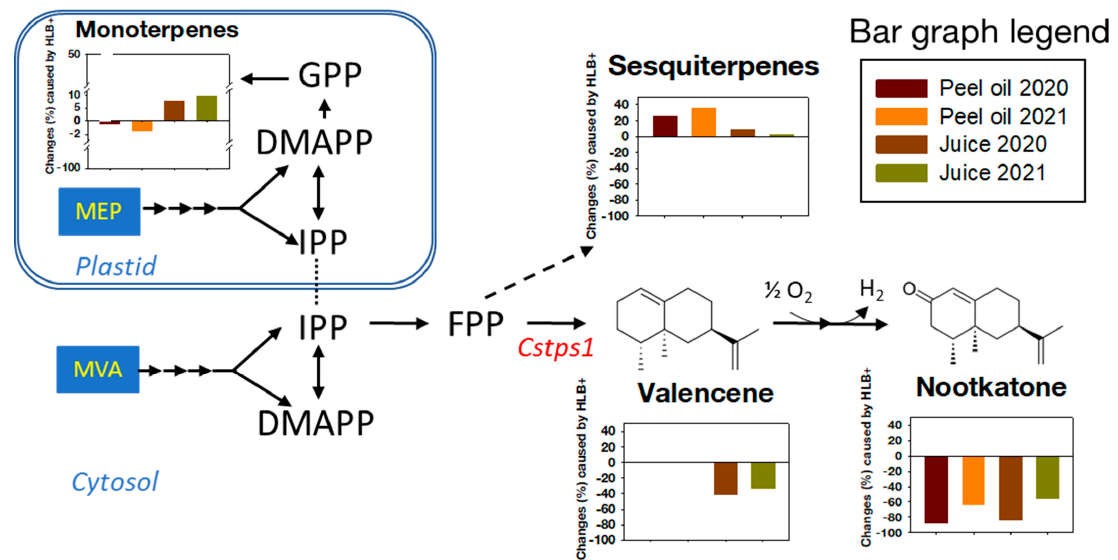
Figure 7. Summary of metabolic pathways leading to monoterpenes, sesquiterpenes, and nootkatones [49,52,53,55]. Bar graphs show changes (%) caused by HLB affection in peel oil and juice in 2020 and 2021. MEP, methylerythritol phosphate pathway; MVA, mevalonic acid pathway; IPP, isopentenyl pyrophosphate; DMAPP, dimethylallyl pyrophosphate; GPP, geranyl pyrophosphate; FPP, farnesyl pyrophosphate; Cstps1, valencene synthase.